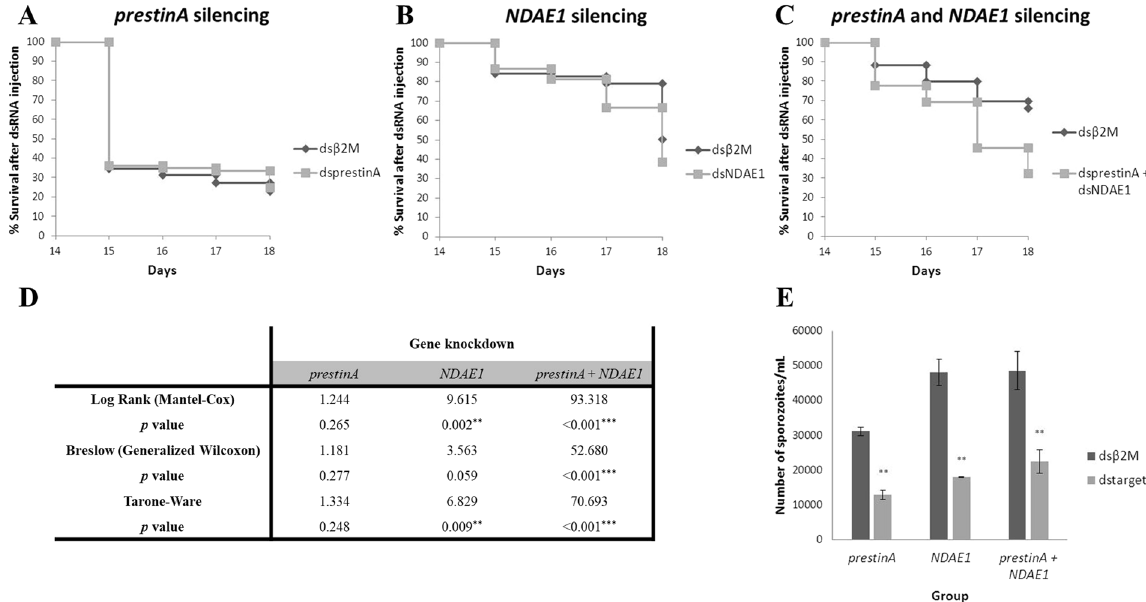
Figure 6. Knockdown of the prestinA and NDAE1 genes in Anopheles stephensi salivary glands. ( A – C ) Kaplan- Meier plots of the survival of Anopheles stephensi mosquitoes after silencing of prestinA ( A ), NDAE1 ( B ), or both genes together ( C ). ( D ) Kaplan-Meier statistics with values from the Log-Rank, Breslow, and Tarone-Ware tests. * P < 0.05, ** P < 0.01, *** P < 0.001. ( E ) Effects of silencing prestinA , NDAE1 , or both genes together in the Anopheles stephensi salivary glands with regards to the number of sporozoites. Distributions were compared using the Mann-Whitney test. * P < 0.05, ** P < 0.01, *** P <